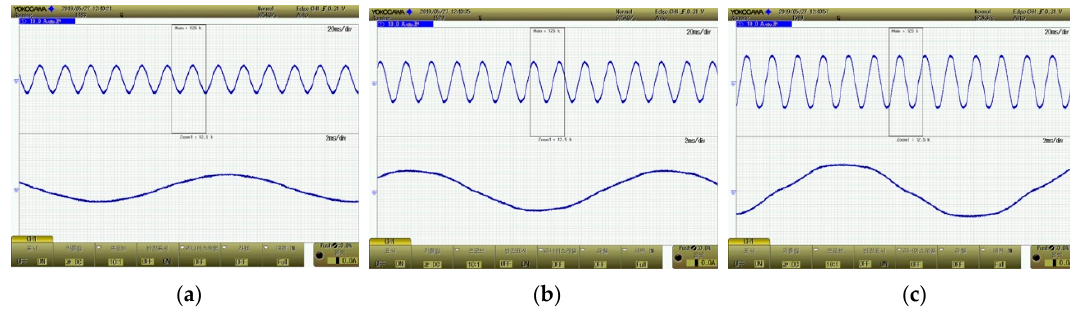
Figure 17. Phase current in U-phase at 1000r/min: ( a ) 10 A peak , ( b ) 15 A peak , ( c ) 20 A peak.